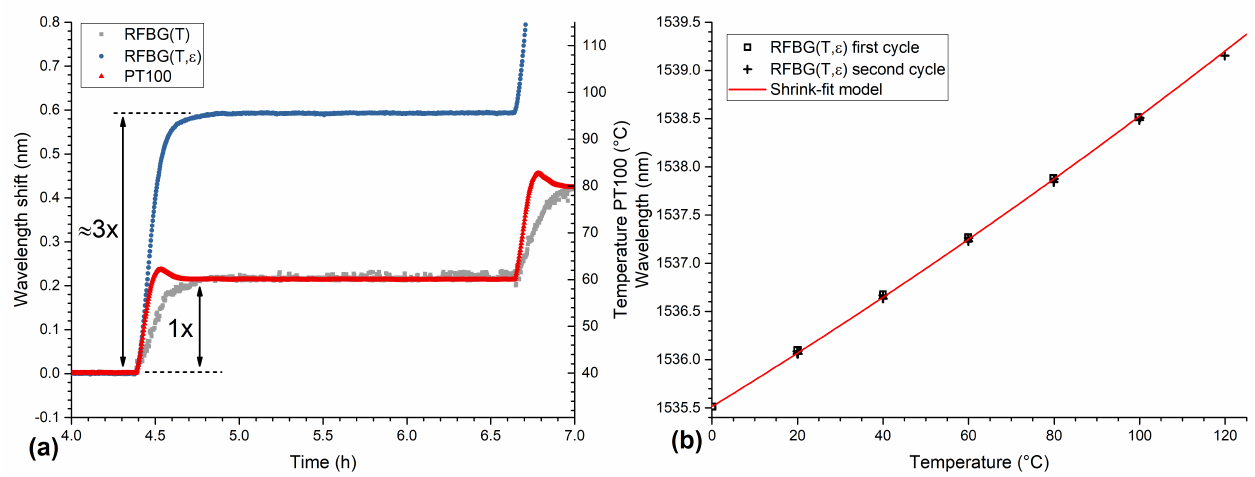
Figure 14. ( a ) Wavelength shift of both RFBG sensors (left axis) from 60°C to 80°C and the temperature from the Pt100 sensor (right axis) as a function of time. Both RFBG sensors show a larger delay than the Pt100 sensor and the embedded strain sensor has an about 3 times larger wavelength shift. ( b ) The wavelength of the embedded RFBG strain sensor (open black squares for the first cycle and crosses for the second cycle) and the theoretical model (red solid line) as functions of temperature. The analytical model agrees well with the